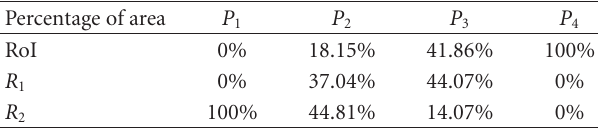
Table 2: The information percentage transmitted for each area during the stages P 1 to P 4 images.